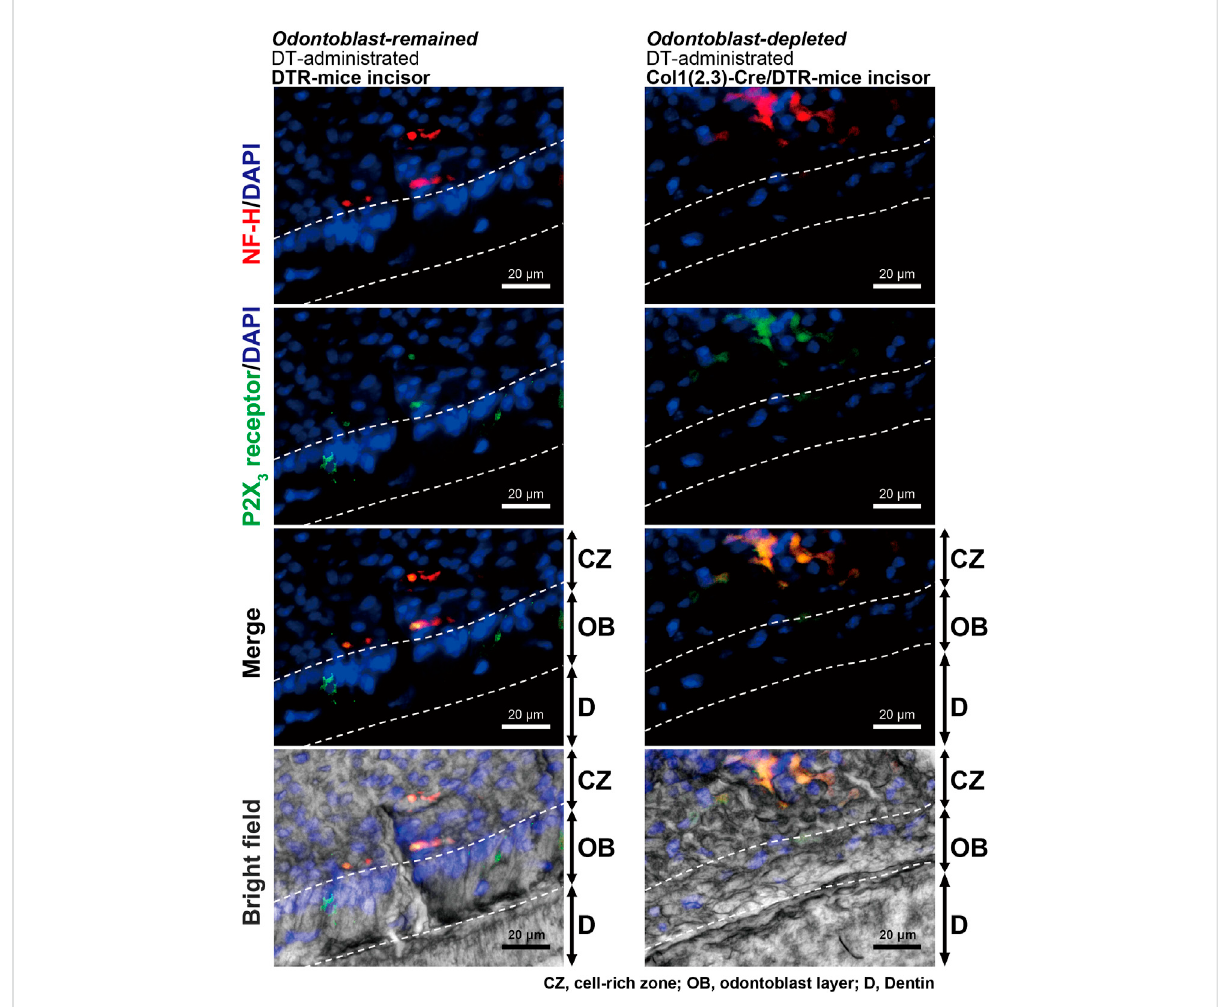
FIGURE 8 Observation of A-neuron marker protein and P2X 3 receptors in incisors of DT-injected DTR-mice and Col1 (2.3)-Cre/DTR-mice after performing a series of measurements of nociceptive scores. Immuno fl uorescence analysis showed that both DT-administered DTR-mice (left panels) and Col1 (2.3)-Cre/DTR-mice (right panels) expressed myelinated A-neuron marker protein, NF-H (red in upper, second lower, and lower), and ionotropic ATP receptor subtype, P2X 3 receptor (green in second upper, second lower and lower), in the sub-odontoblastic region of the lower incisors. CZ, cell-rich zone; OB, odontoblast layer; and D, dentin. Nuclei (DAPI) are shown in blue. Scale bars, 20 μ